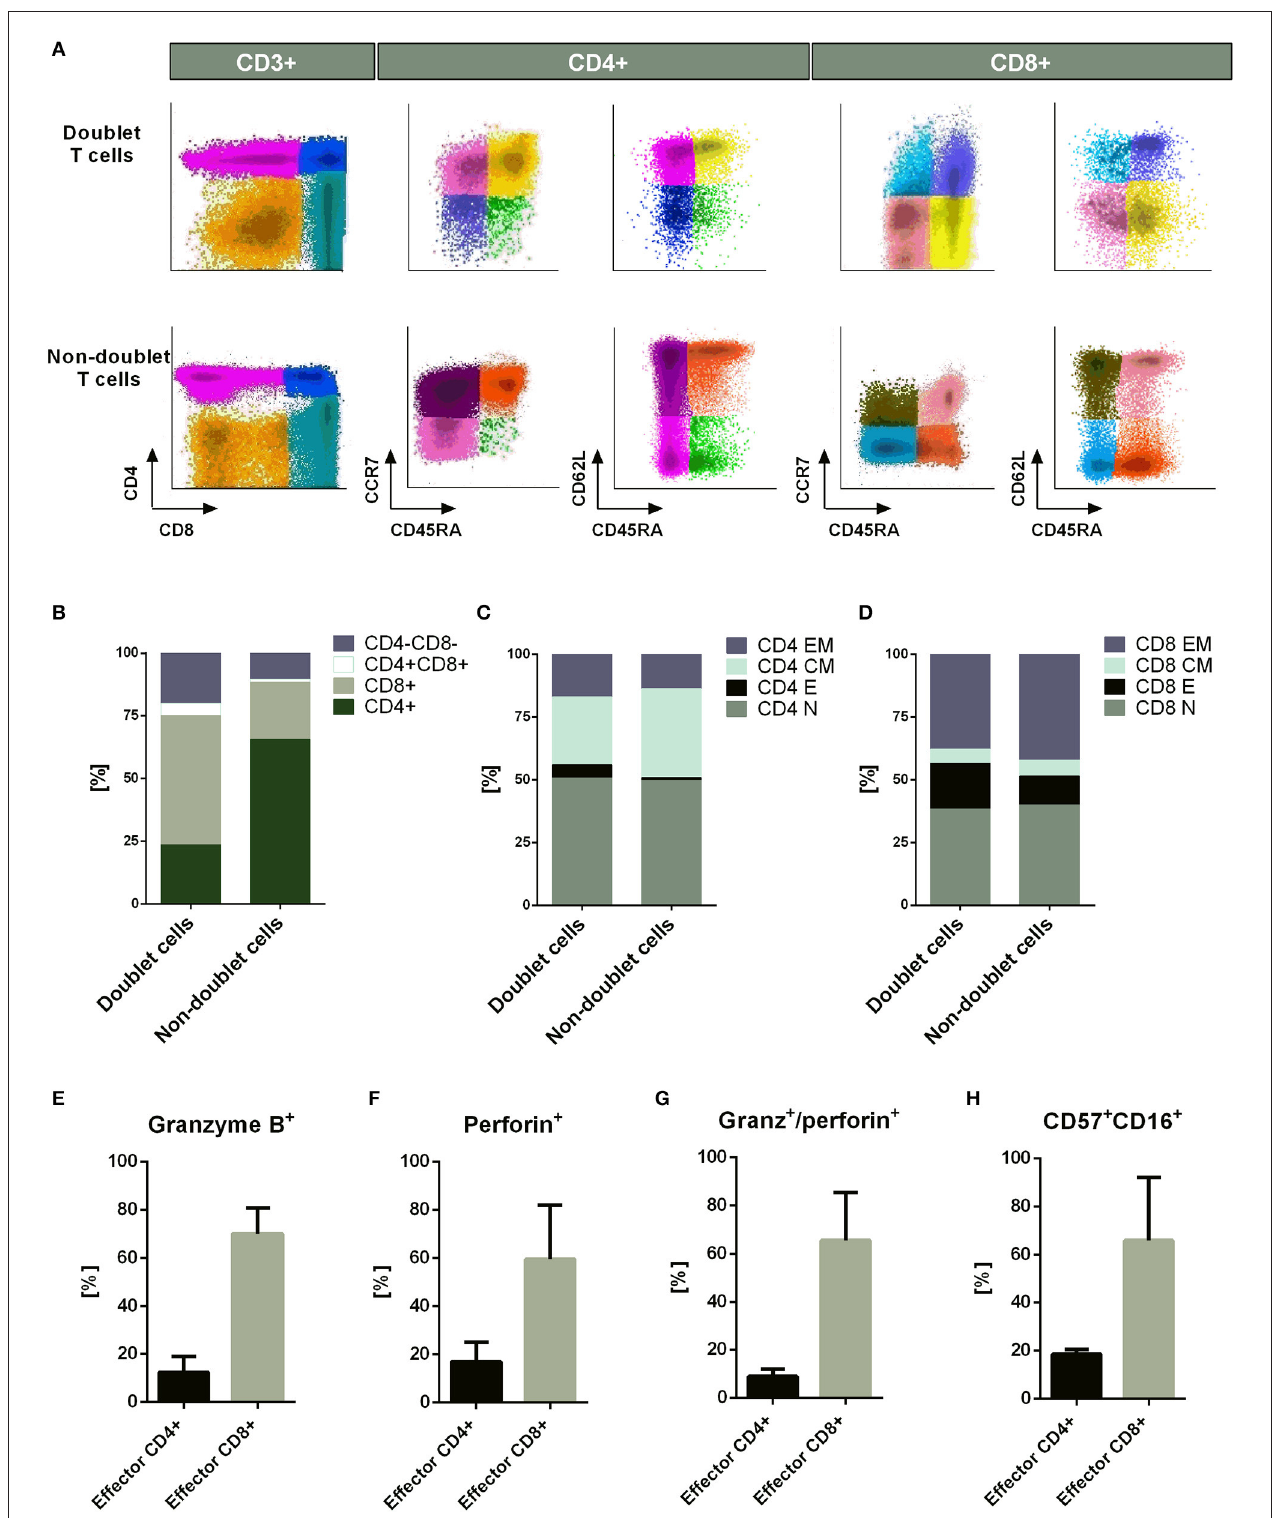
FIGURE 2 | Immunophenotype of doublet-forming T cells. (A) Dot plots show the expression of CD4, CD8, CD45RA, CD62L, and CCR7 on doublet T cells (upper panel) and non-doublet T cells (bottom panel) from one representative case ( n = 6 experiments). The T cell-subtypes: naïve (CD45RA + CCR7 + CD62L + ),